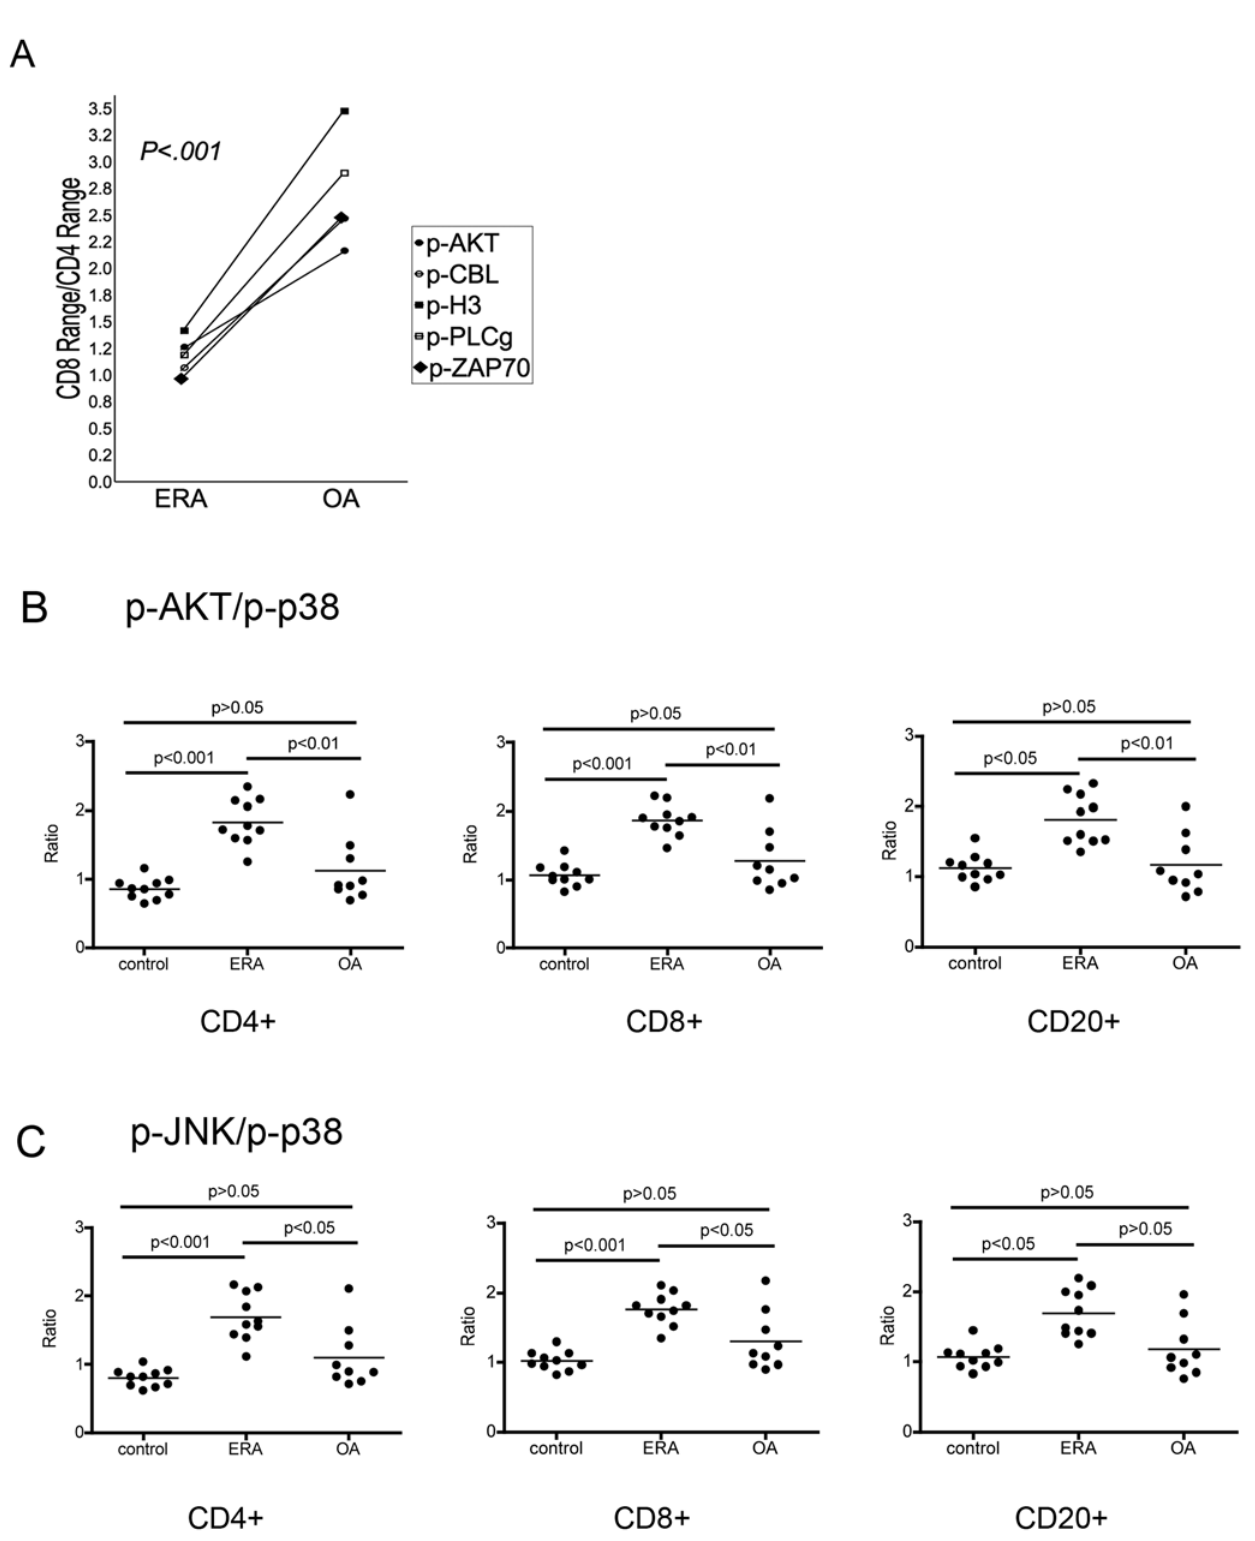
Figure 4. Quantitative differences in phospho MFI values distinguish ERA. The data from Figure 3 are plotted to (A) compare the CD8 MFI range/CD4 MFI range for each of p-AKT, p-CBL, p-H3, p-PLC c and p-ZAP70 and (B) to compare the p-AKT/p-p38 and p-JNK/p-p38 ratios, between ERA (n=10) and OA (n=9) patients, in the indicated cell populations. Significant differences were determined by ANOVA followed by Tukey’s multiple comparison (p , 0.05).